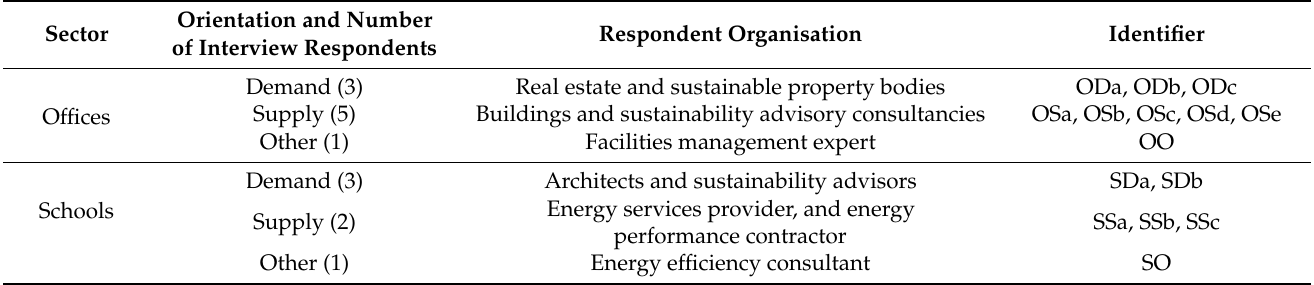
Table 1. Completed interviews and anonymised identifiers used in the